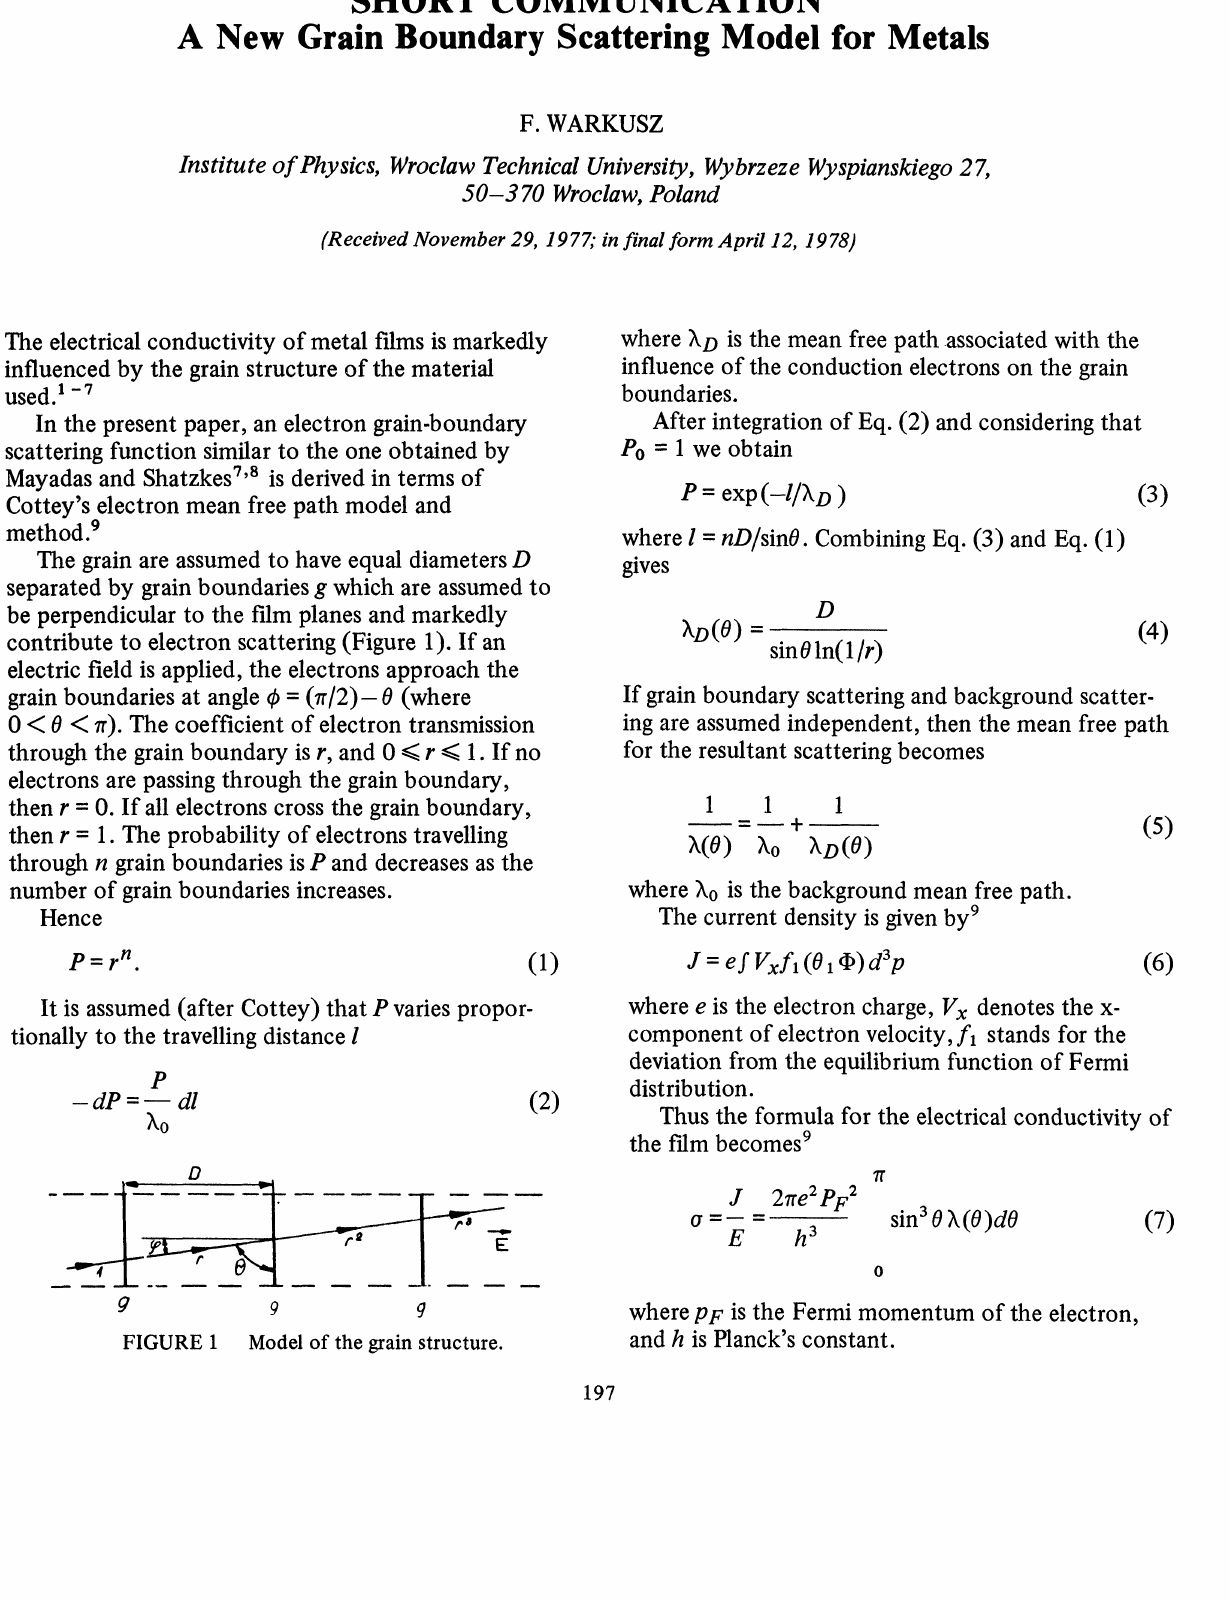
FIGURE Model of the grain